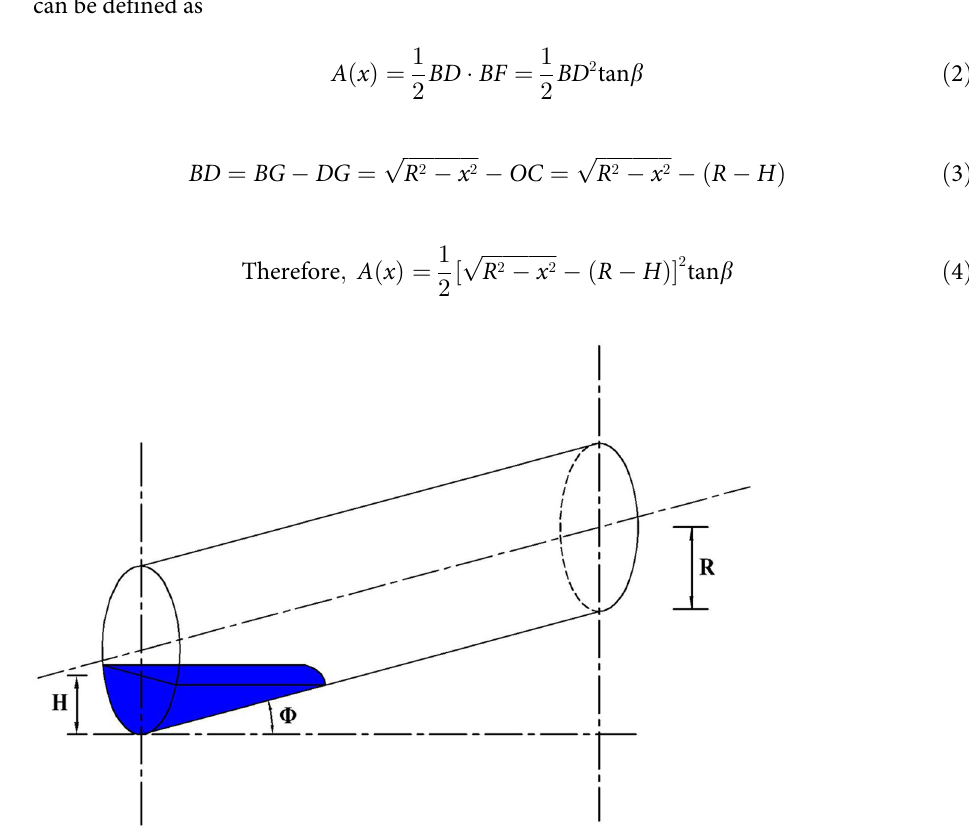
Fig 1. Road surface water accumulation Model